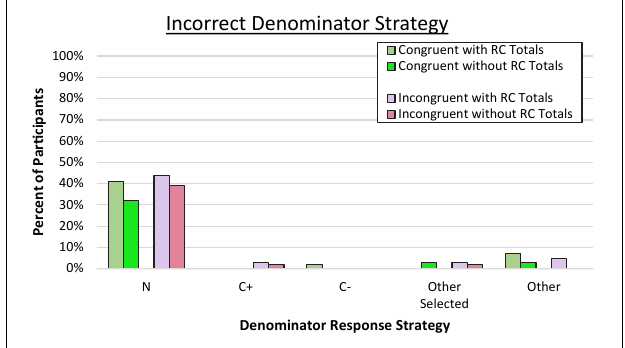
FIGURE 4 | Proportion of participants who consistently used an incorrect denominator strategy on the frequency response format. N denotes the total in the superordinate set (i.e., sample size), C ± denotes the total number of people who have or do not have the condition.